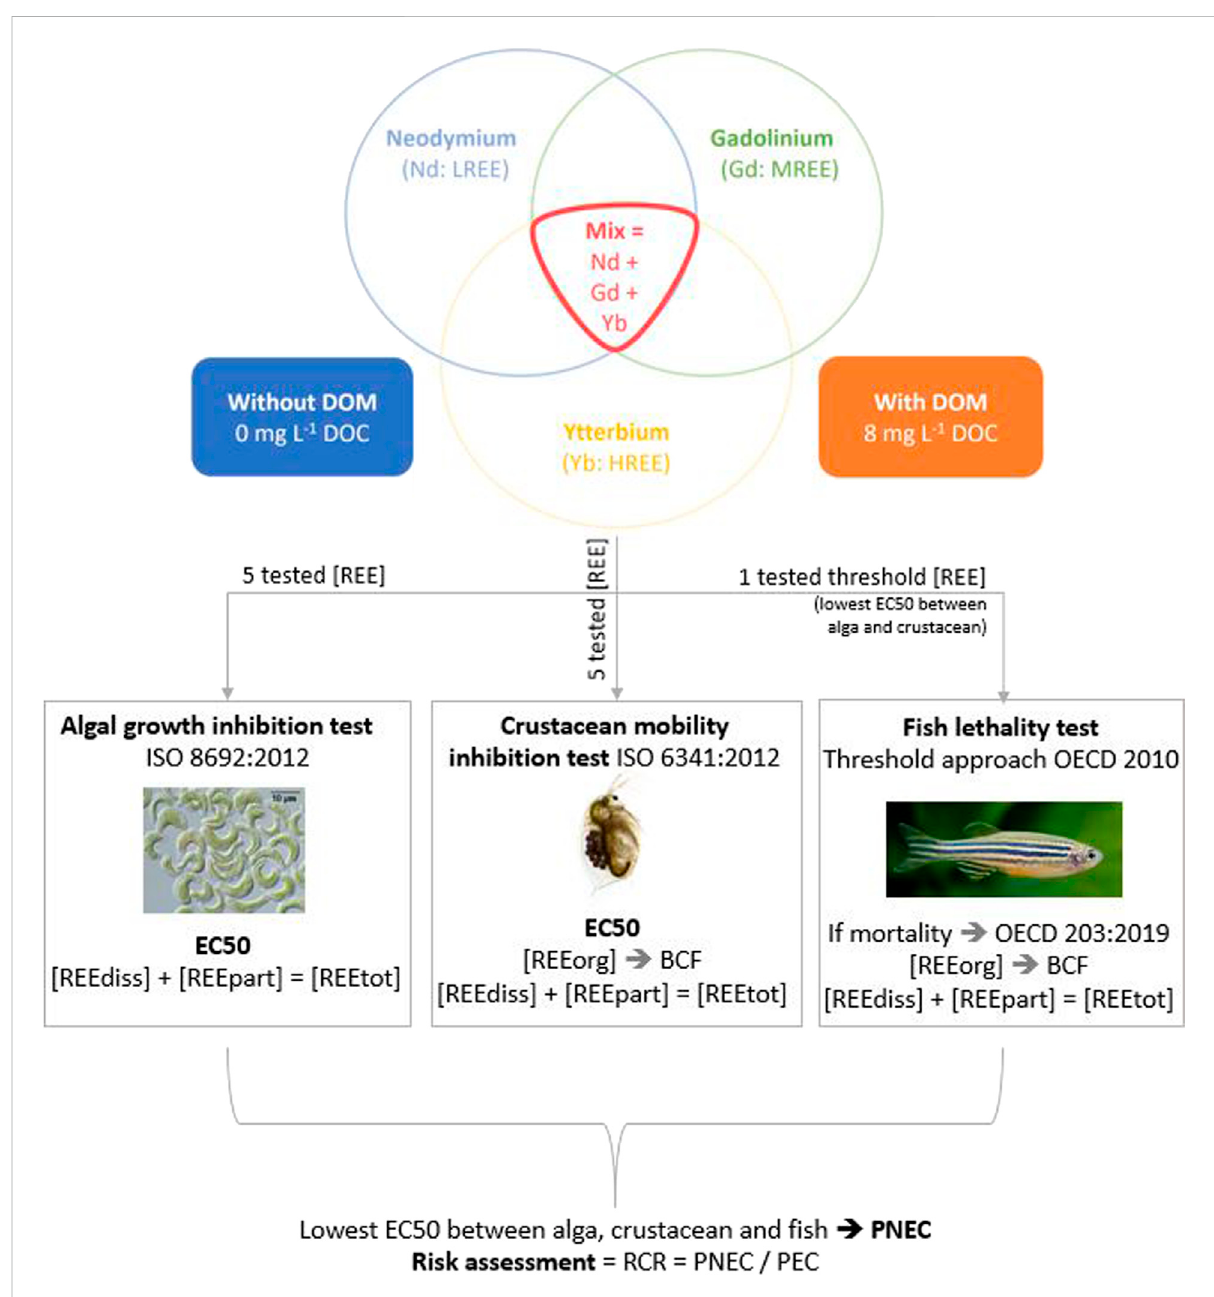
FIGURE 1 Synthetic experimental approach used to assess the risk of REE in freshwater systems. LREE, light rare earth element; MREE, medium rare earth element; HREE, heavy rare earth element; [REE], rare earth element concentration. Text below the pictures refer to the parameters calculated or measured at the end of each test: EC50 = effective concentration 50%; [REEdiss] = dissolved ( < 0.45 µm) REE concentration measured at t1; [REEpart] = particulate ( > 0.45 µm) REE concentration measured at t1; [REEtot] = calculated total ([REEdiss] + [REEpart]) REE concentration; BCF = bioconcentration factor. PNEC, predicted no effect concentration; PEC, predicted environmental concentration; RCR, risk characterisation